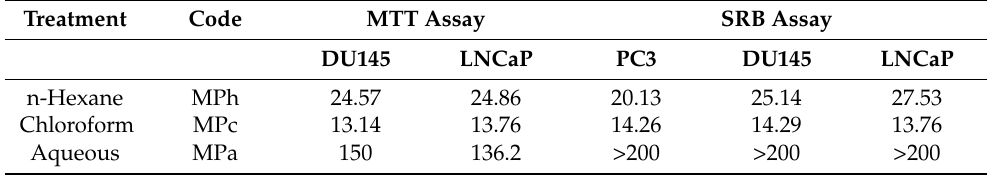
Table 1. Cytotoxic activity (IC50 values in µ g/mL) of the extracts against the selected prostate cancer cell lines. MTT measures mitochondrial viability, and SRB measures cell